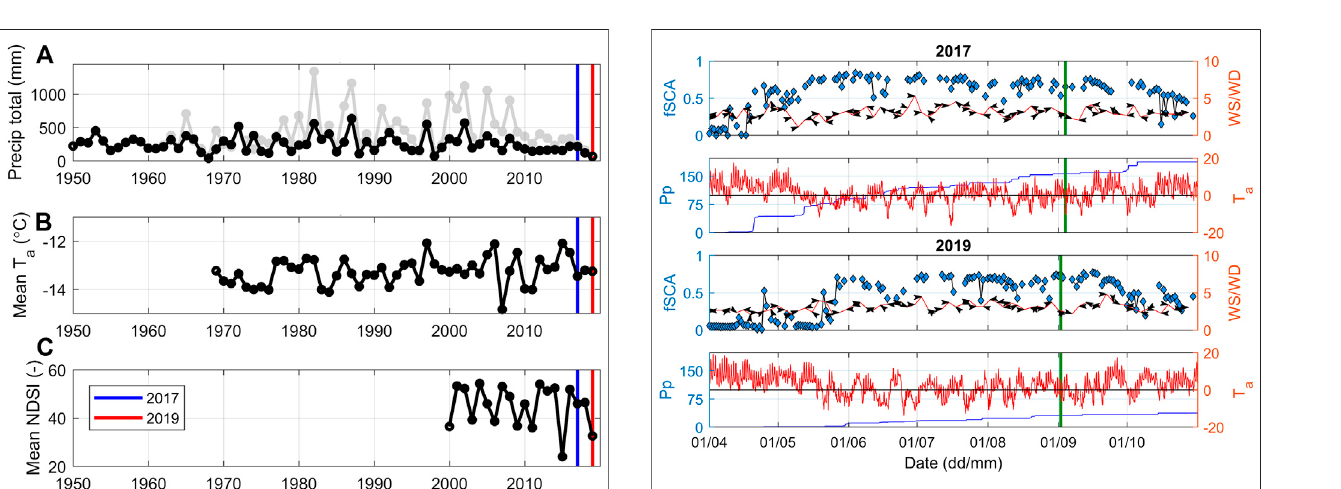
FIGURE 3 | The historical records of (A) total precipitation (mm) for Quinta Normal (black) and Yeso Embalse (grey) and (B) mean winter air temperature ( ° C) at Quinta Normal ( Figure 1 ) lapsed to the mean elevation of the catchment (4,150 m a.s.l.) using the environmental lapse rate ( − 6.5 ° Ckm-1).PanelcshowsthemeanNDSIderivedfromMODISMOD10A1 V6fortheRioYesocatchment.Allannualsums/meansrepresenttheperiodof 1st April – 3rd September. The years 2017 and 2019 are marked.